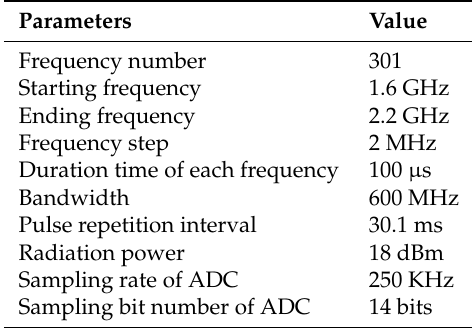
Figure 3. Block diagram of the single-channel SFCW radar. Table 1. The key parameters of SFCW